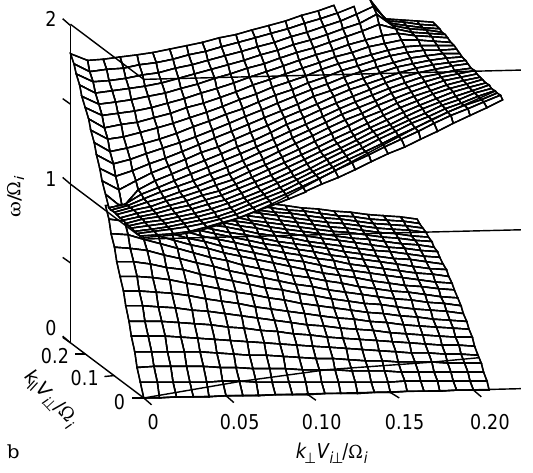
Fig. 3. a The distribution of wave-power in the frequency-wave vector plane in arbitrary units. Most of the wave-power is located where the plasma dispersion relation is satisfied. Ion acoustic waves can be seen